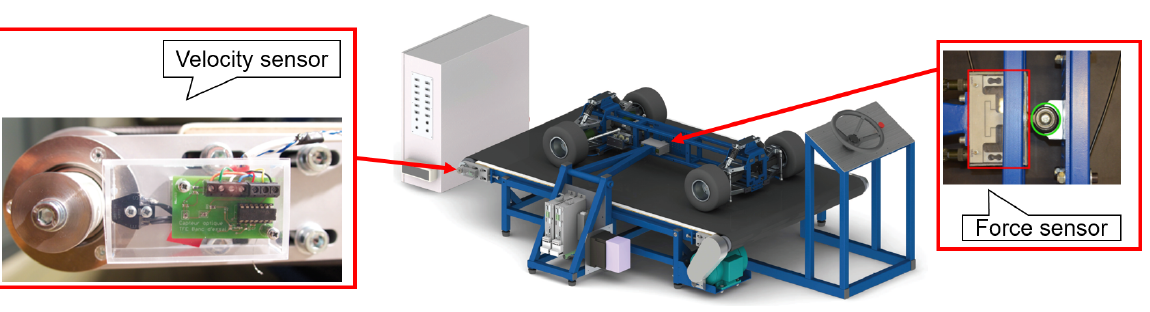
Figure 32. Sensors of the kart